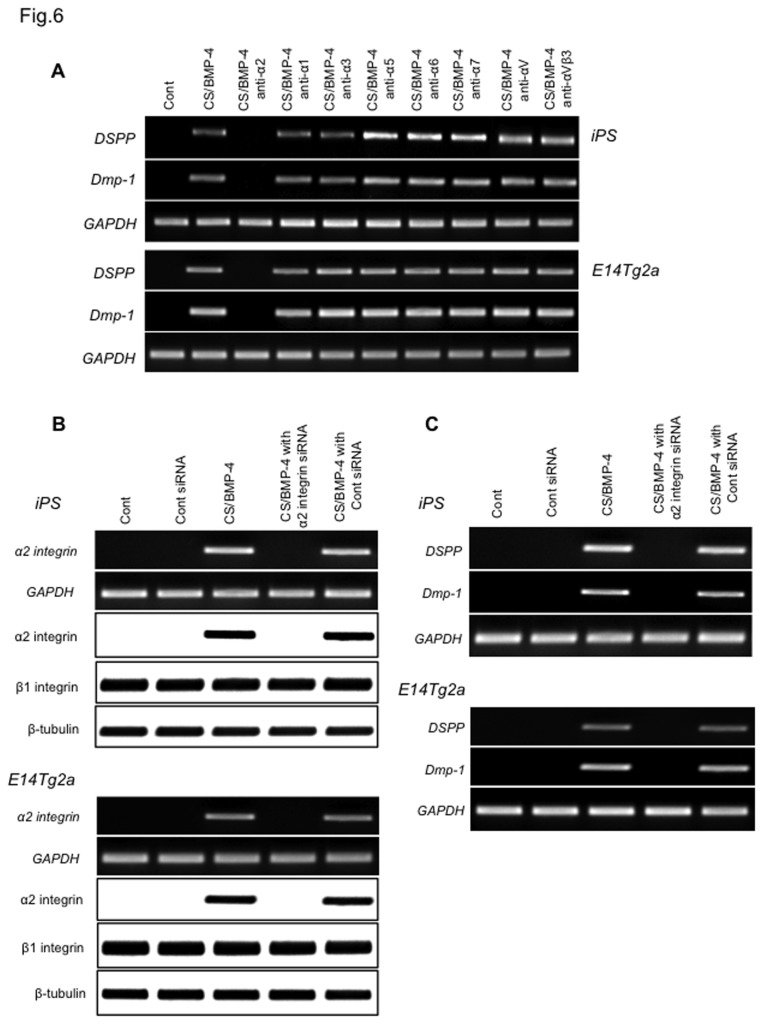
Effect of anti-integrin antibodies and siRNA silencing on induction of odontoblastic markers.(A) The expression of odontoblastic marker mRNAs (DSPP and Dmp-1) in CS/BMP-4 differentiated iPS cells and in E14Tg2a odontoblastic cells was assessed by RT-PCR following culture in the presence of various anti-integrin monoclonal antibodies (5 μg/ml). No significant cross-reactivity with other integrin proteins was observed for these antibodies. Images shown are representative of at least three independent experiments. (B) The effect of transfection of iPS cells and E14Tg2a cells with an integrin α2-specific siRNA. Images show RT-PCR analysis of integrin α2 mRNA expression in cells 24 h after transfection with siRNA (top panels), with expression of the housekeeping gene, GAPDH, as a control (second panels). Western blot analysis (lower three panels) show integrin α2 protein expression in these cells 24 h after siRNA transfection. (C) As in B, iPS cells and E14Tg2a cells were treated with an integrin α2-specific siRNA and the expression of DSPP and Dmp-1 mRNA and protein were measured.